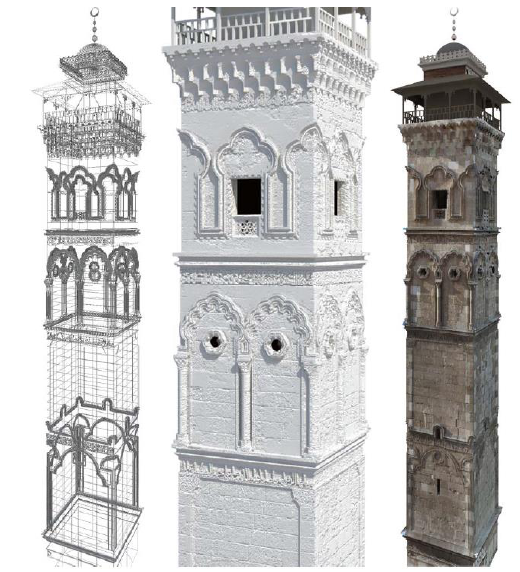
Figure 15: The 3D model of the minaret by Wissam Wabeh.